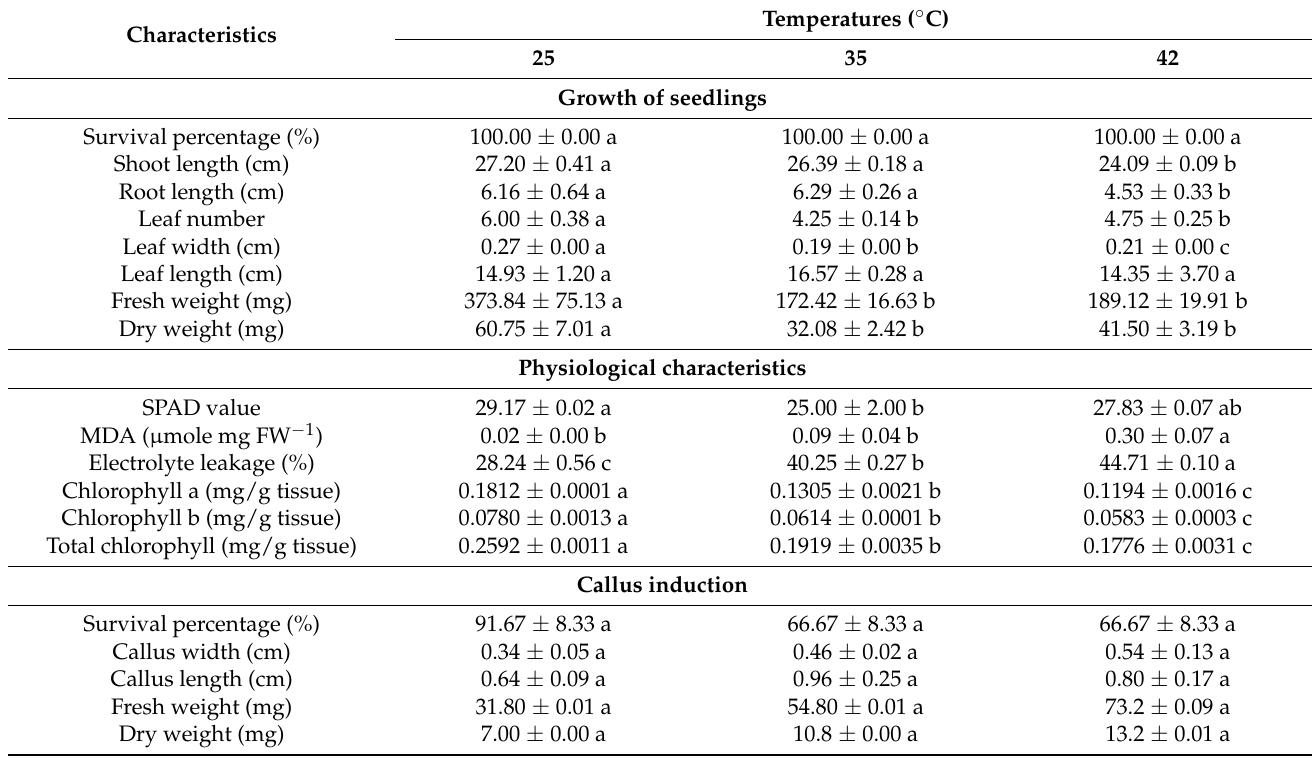
Table 1. Growth, physiological and anatomical responses of KDML105 seedlings and callus induction efficiency from KDML105 seeds after treatment at 25 (control), 35 and 40 ◦